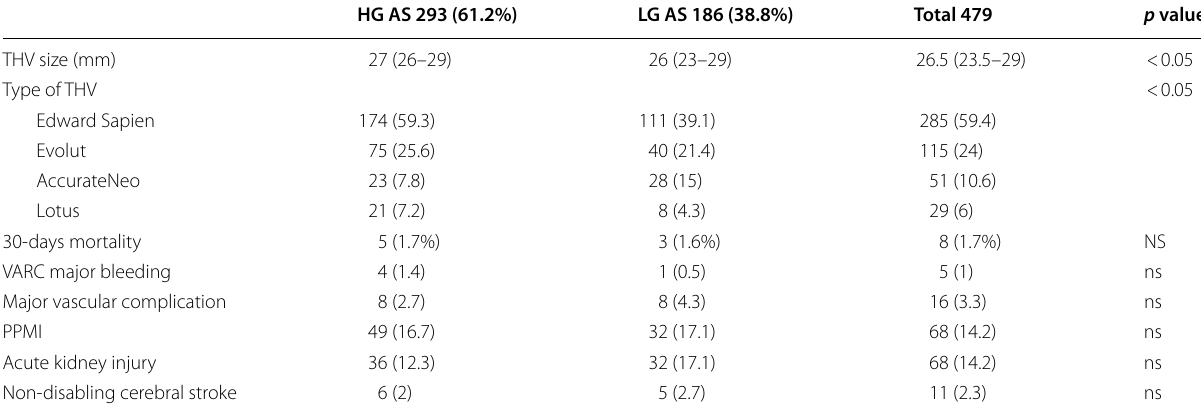
Table 3 Operative and postoperative